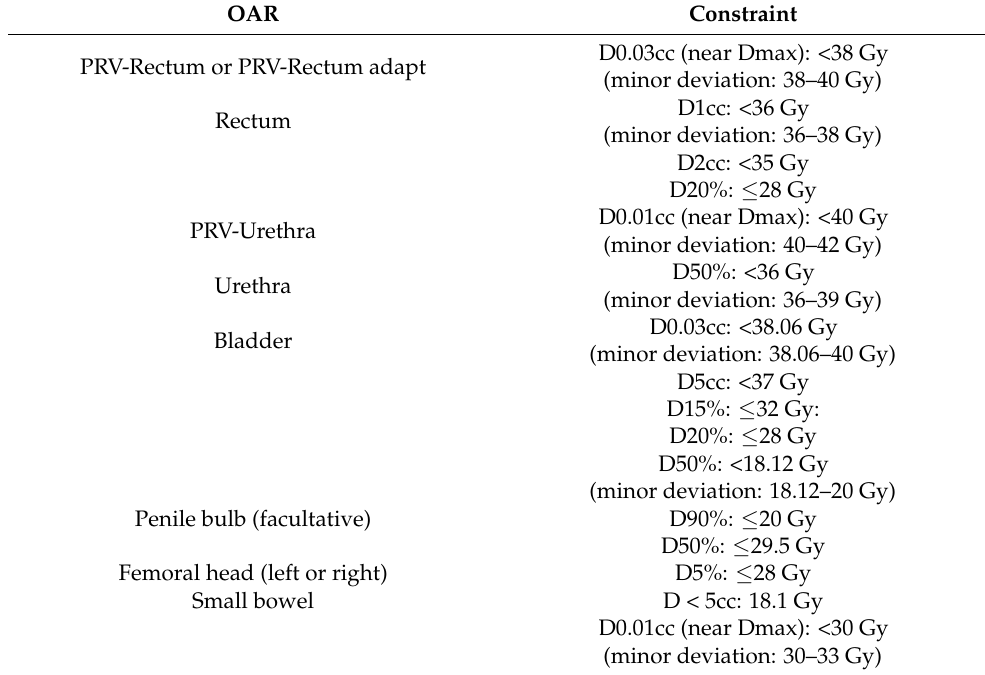
Table 3. Dose constraints for organs at risk for stereotactic body radiotherapy in 5 fractions (ex- perimental arm). PRV-Rectum_adapt is created by 2 mm isotropic expansion of Rectum_adapt. Rectum_adapt will be generated by delineation of the rectum in the co-registered CB-CTs, MV-CTs or MRI images of the first three fractions. Manual delineation of the Rectum_adapt should consider the mean rectal volume.